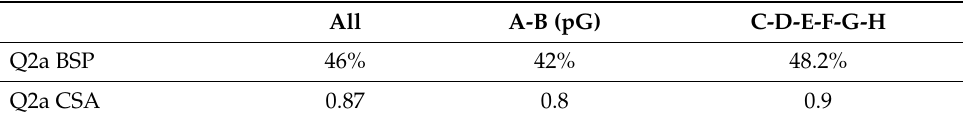
Table 4. Performance of players and non-players in Q2a questionnaire. All A-B (pG)